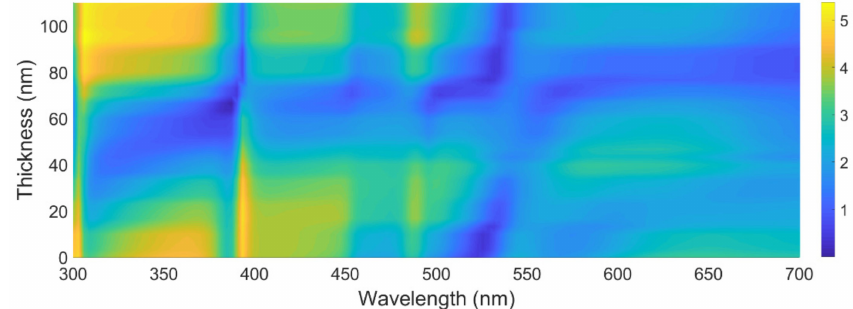
Figure 7. Map of electric field distribution inside the absorber layer versus the